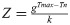
Varying P. berghei sporozoite inoculation to obtain an estimate of blood-stage growth rate by non-linear curve fitting.Dilution series of wild-type (A) or PvCSP-210/PvTRAP transgenic (B) P. berghei were intravenously injected into 6–8 week old BALB/c mice and time to 1% blood stage parasitaemia was inferred by linear regression from daily thin blood smears. Curve-fitting to the equation Z=gTmax−Tnk was performed using Prism to obtain a value for the growth rate g where Z is the number of sporozoites injected, Tmax maximum time-to-1%, TN time-to-1% in a challenged mouse, and k the infectivity of sporozoites. A value of g = 4.0 ± 1.5 was obtained from (A, n = 24) and g = 3.6 ± 0.9 from (B, n = 46). Best fit values given ± SEM.